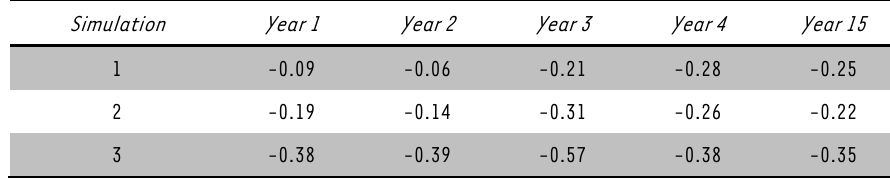
TABLE 1: Impact on Consumer Price Index (% change from BAU)